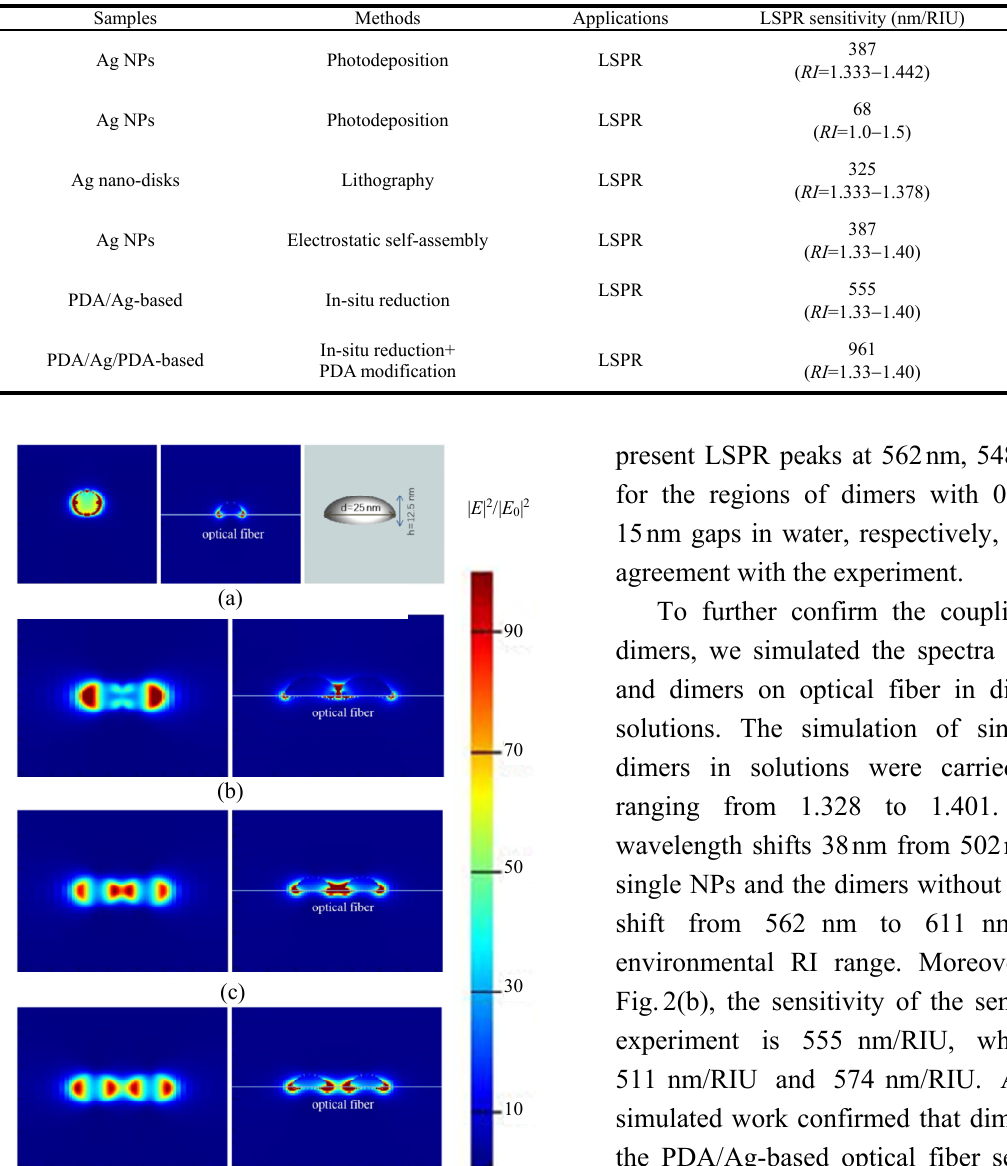
Table 1 Sensitivity comparisons of the fabricated PDA/Ag/PDA-based LSPR sensor with other Ag sensors.